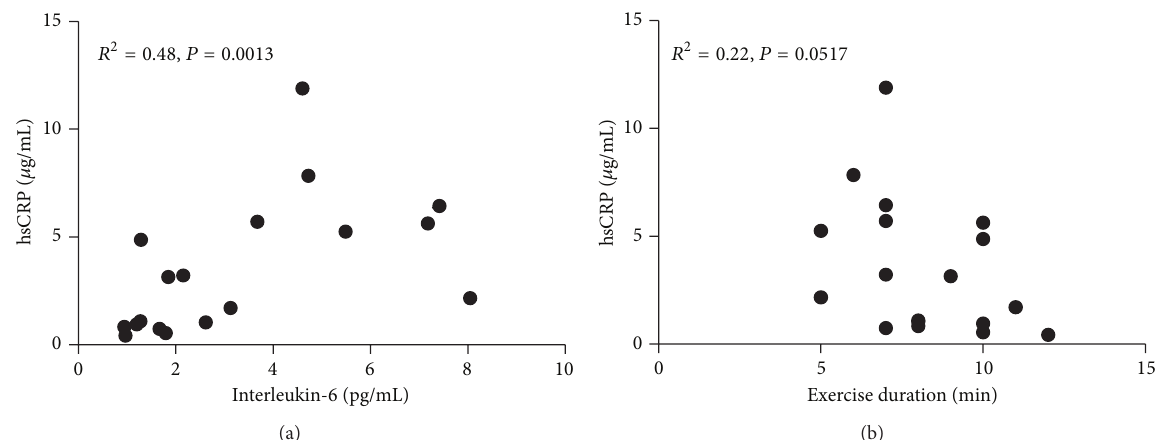
Figure 3: Relationships between selected inflammatory biomarkers and exercise duration in patients with HFpEF. hsCRP: high-sensitivity C-reactive protein; 𝑅 2 : coefficient of determination.